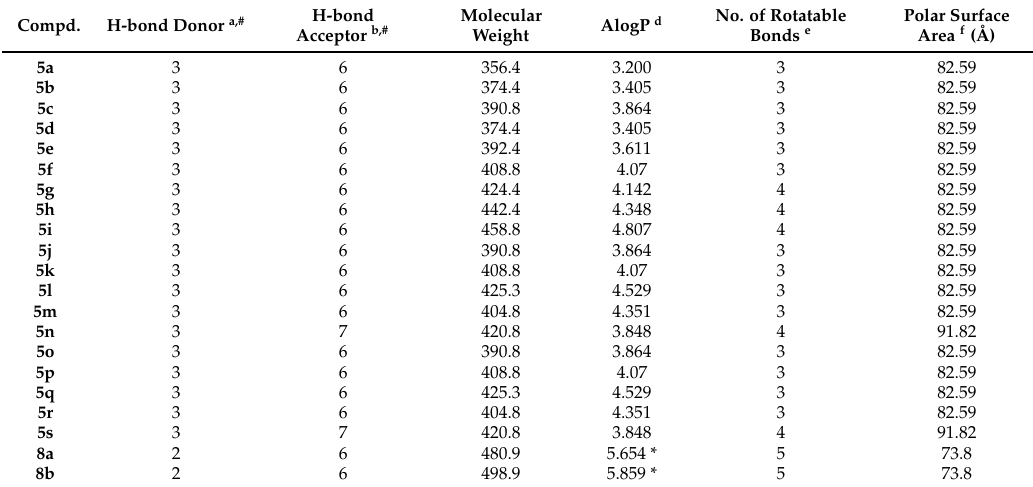
Table 2. Lipinski rule of five parameters results for all the synthesized